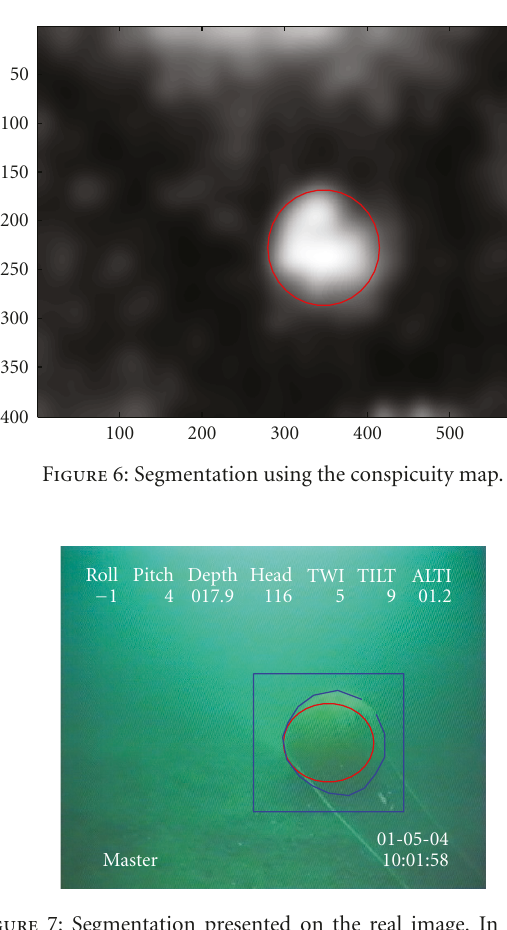
Figure 9: Segmentation of a mine in basin. C good = 0 . 86 and C false = 10 − 3